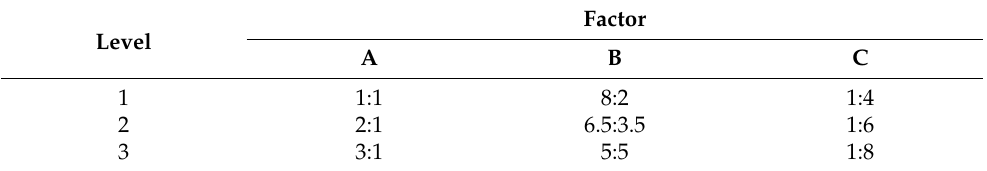
Table 6. Orthogonal test of factors and